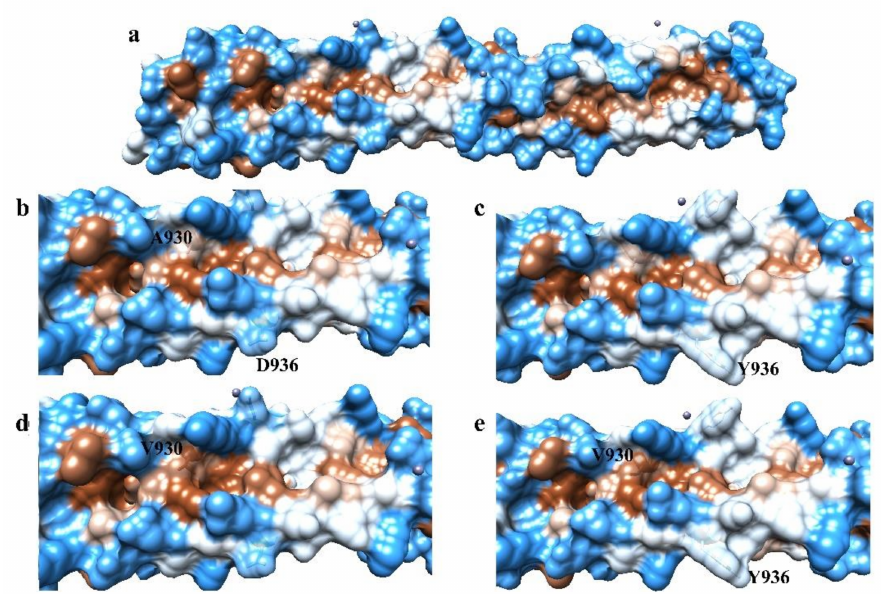
Figure 3. Hydrophobicity plots shown on surface of HR1 domains of SARS-CoV-2: ( a ) full structure WT. Expanded surface of the regions found to contain mutated residues of the SARS-CoV-2. ( b ) WT, ( c ) D936Y, ( d ) A930V, and ( e ) A930V-D936Y variants. The blue color indicates hydrophilic regions, the brown color indicates hydrophobic regions. The white color indicates regions neither strongly hydrophilic nor hydrophobic. The darker the shade, the greater the degree of either hydrophobicity or